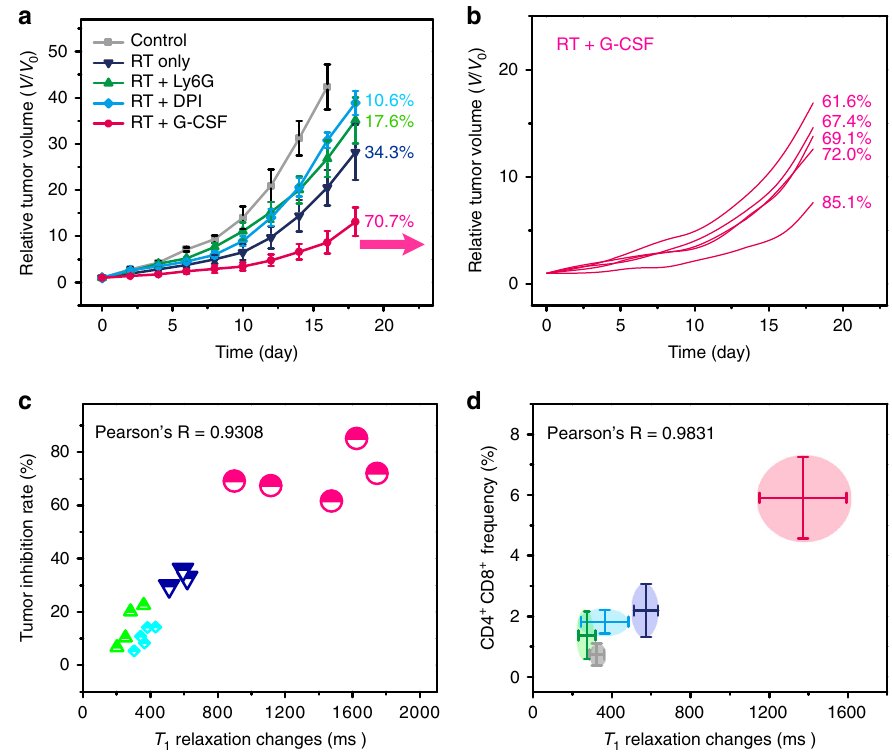
Fig. 6 Strati fi cation of the RT study in Balb/c mouse 4T1 tumor models. a The tumor growth curves of mouse groups ( n = 5 biologically independent mice) with different treatments, including control, RT (15 Gy) only, RT + aLy6G, RT + DPI, and RT + G-CSF. The overall tumor inhibition rates are presented after each curve. b Individual tumor growth curves and the corresponding tumor inhibition rates for mouse treated with RT + G-CSF. c The correlations between the T 1 relaxation time change and the corresponding tumor inhibition rate for individual mouse from different treatment groups except for the control. The Pearson ’ s correlation coef fi cient R is 0.9308. Mouse individuals are shown and mouse groups are indicated by different colors and symbols. d The correlations between the T 1 relaxation time changes (with errors) and the CD4 + CD8 + T cells (with errors) for mouse groups receiving different treatments. The Pearson ’ s correlation coef fi cient R is 0.9831. All error bars indicate mean ±